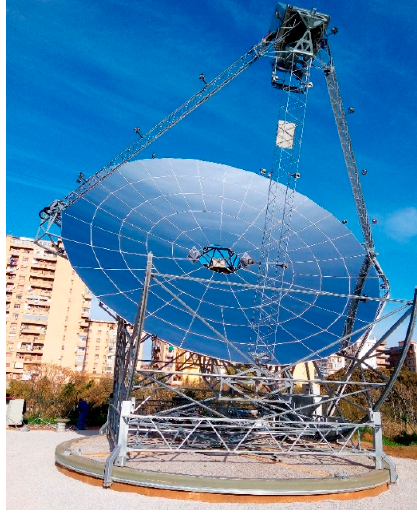
Figure 4. The dish-Stirling solar concentrator installed in the test site of Palermo (Italy). Table 2. Typical parameters of the dish-Stirling system located in Palermo [24].